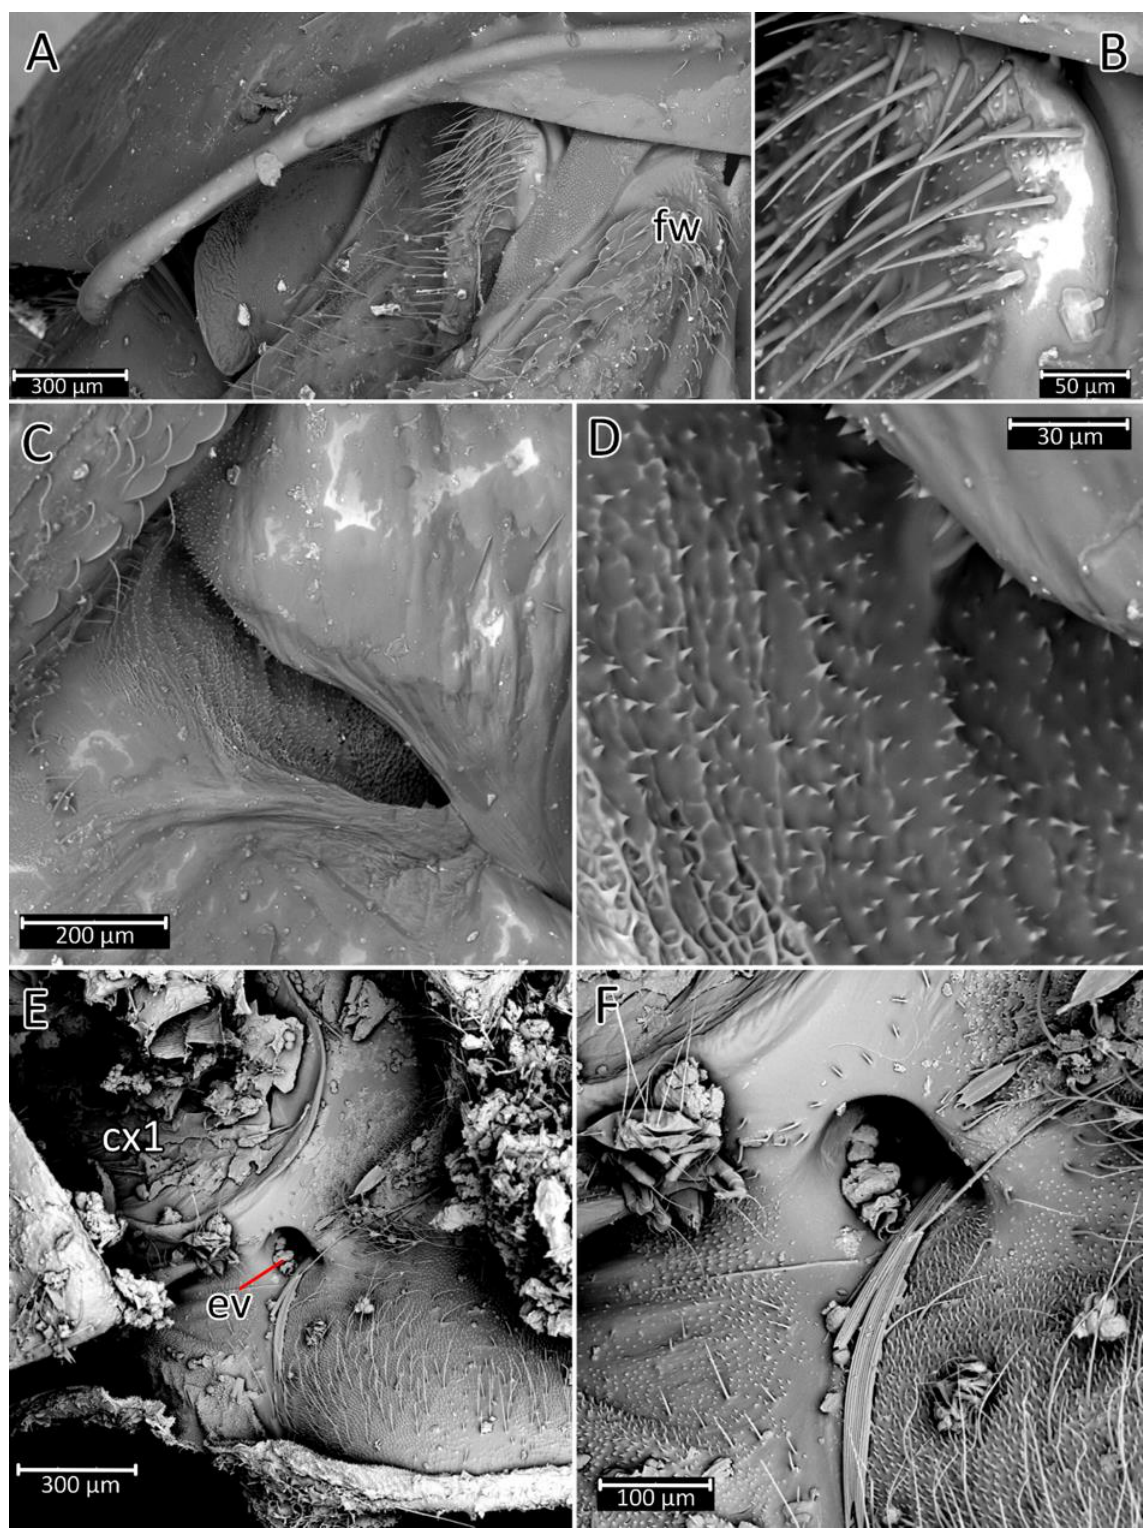
Figure 15. Phonoctonus luridus Miller, 1950: ( A ) structure of central depression of scutellum with sensilla under the pronotum, lateral view; ( B ) magnification of the plate with sensilla. P. nigrofasciatus Stål, 1855: ( C ) Metathoracic spiracle and ( D ) magnification of its inner surface covered by microtrichia. P. fasciatus (Beauvois, 1805): ( E ) Evaporatorium under procoxal and ( F ) its magnification. cx1 — procoxal cavity; ev — evaporatorium; fw — fore wing.